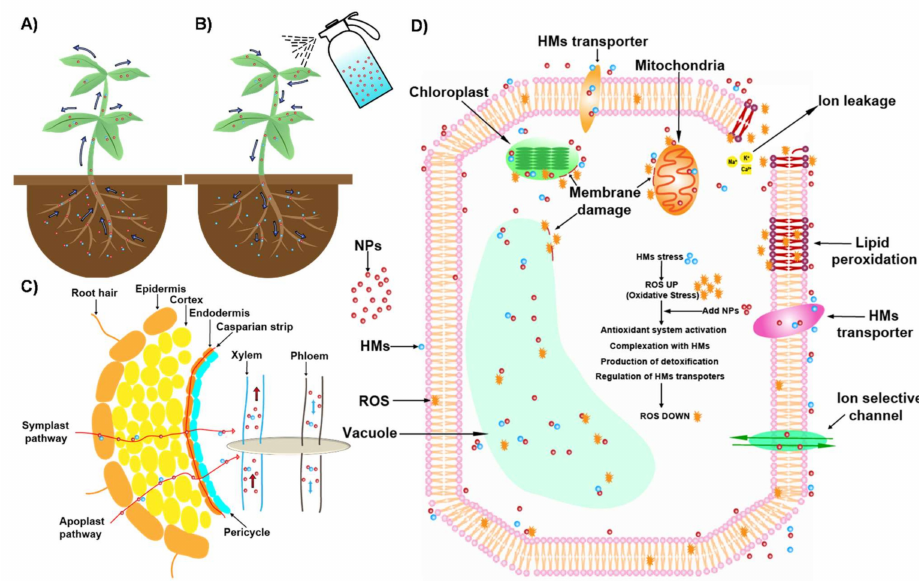
Figure 4. Schematic diagram of possible mechanisms of NPs to alleviate the HM stress in roots and cells. ( A ) Soil application of NPs to plant under HM stress. ( B ) Foliar spaying of NPs to plant under HM stress. ( C ) NPs enter plants possibly through symplast and apoplast. ( D ) Possible mechanisms of NPs to alleviate the damages caused by